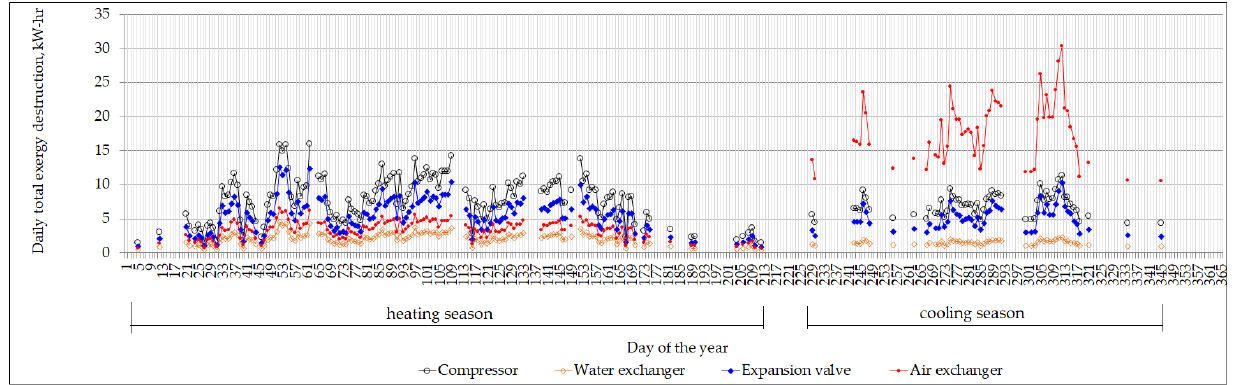
E (kWh) within the components of the (kWh) within the components of the D,k D , k